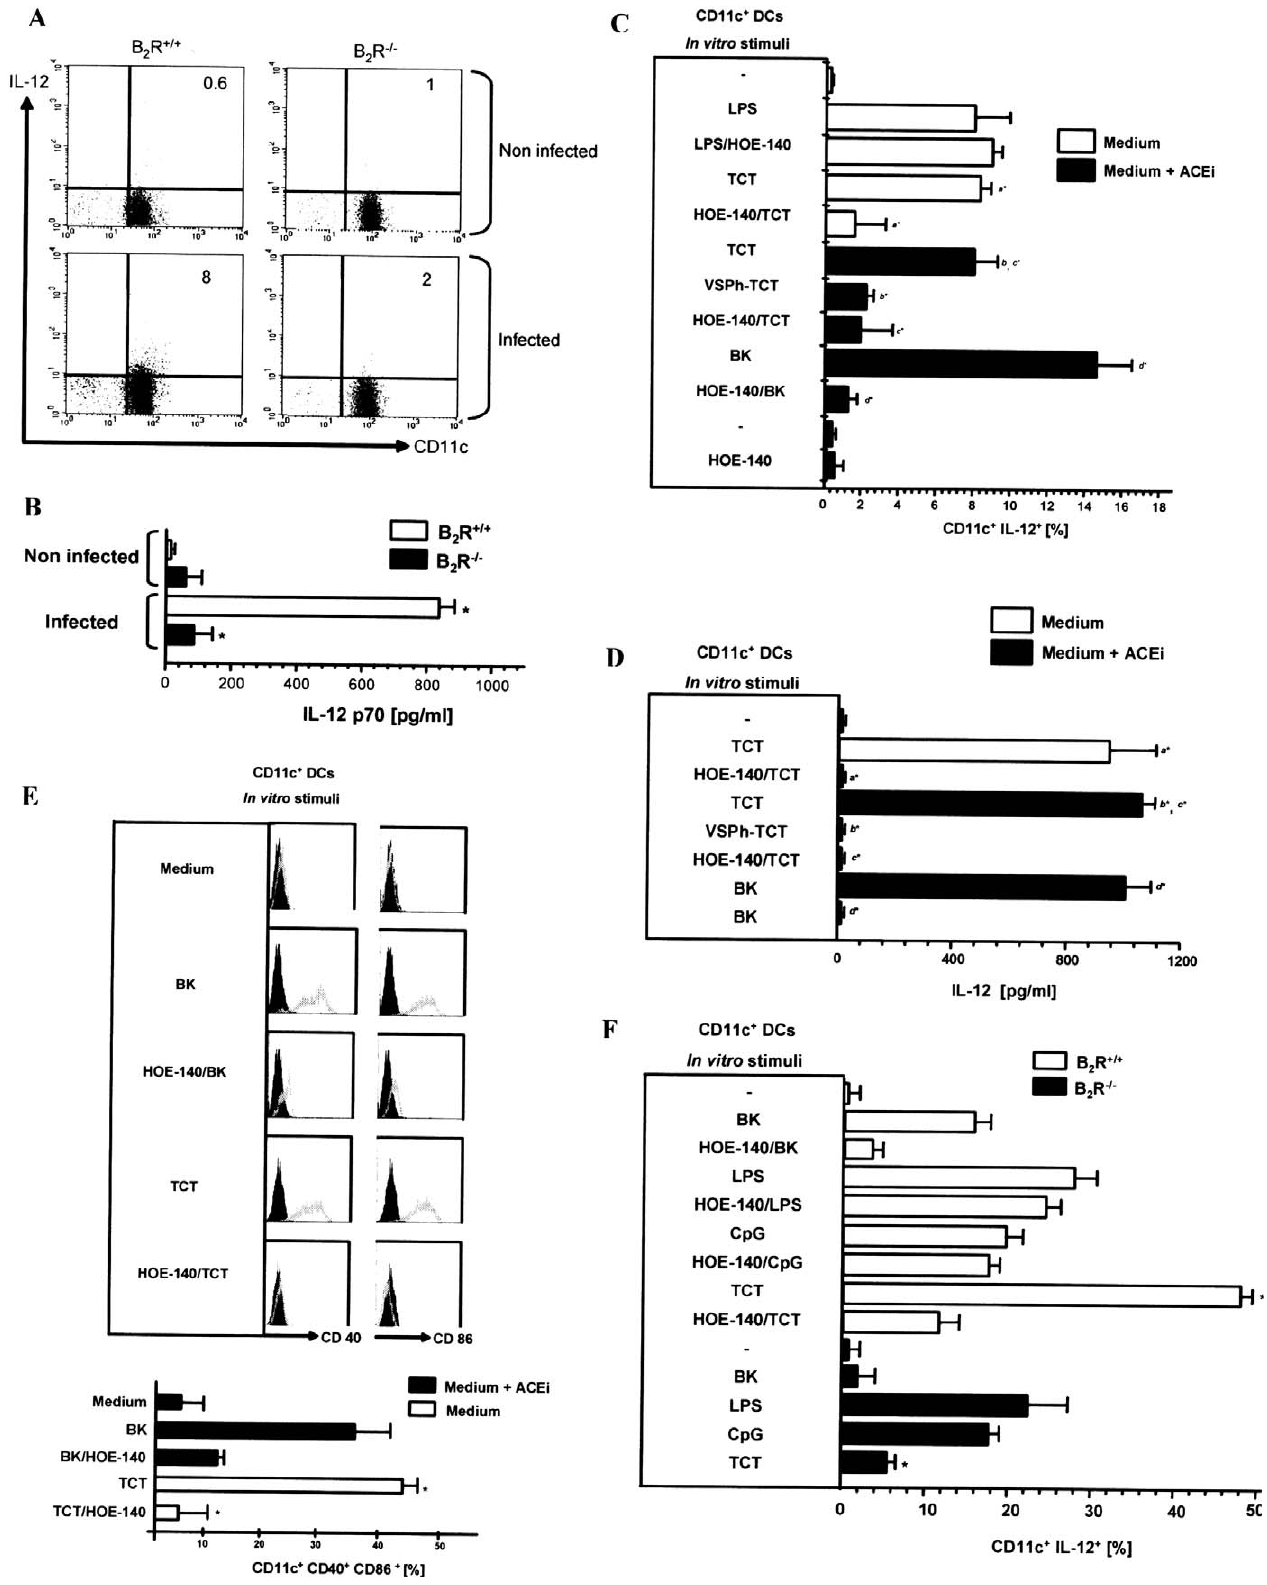
Figure 7. CD11c þ DCs Sense TCT via the Kinin/B 2 R Activation Pathway (A) IL-12 production by splenic CD11c þ DCs of infected mice. B 2 R þ / þ and B 2 R (cid:2) / (cid:2) male mice were infected with 1 3 10 6 TCT intravenously. Non-infected animals served as control. CD11c þ DCs were isolated from spleen of infected mice at 18 h p.i. and cultured in RPMI complete medium. FACS profiles were done with CD11c-FITC and anti-IL12-PE ( n ¼ 6 mice/group). (B) ELISA determination of IL-12 production by CD11c þ DCs from B 2 R þ / þ and B 2 R (cid:2) / (cid:2) mice non-infected and infected with 1 3 10 6 TCT intravenously. Statistics were done by ANOVA and pair-wise comparisons were done by the Tukey test (*, p , 0.01). PLoS Pathogens |